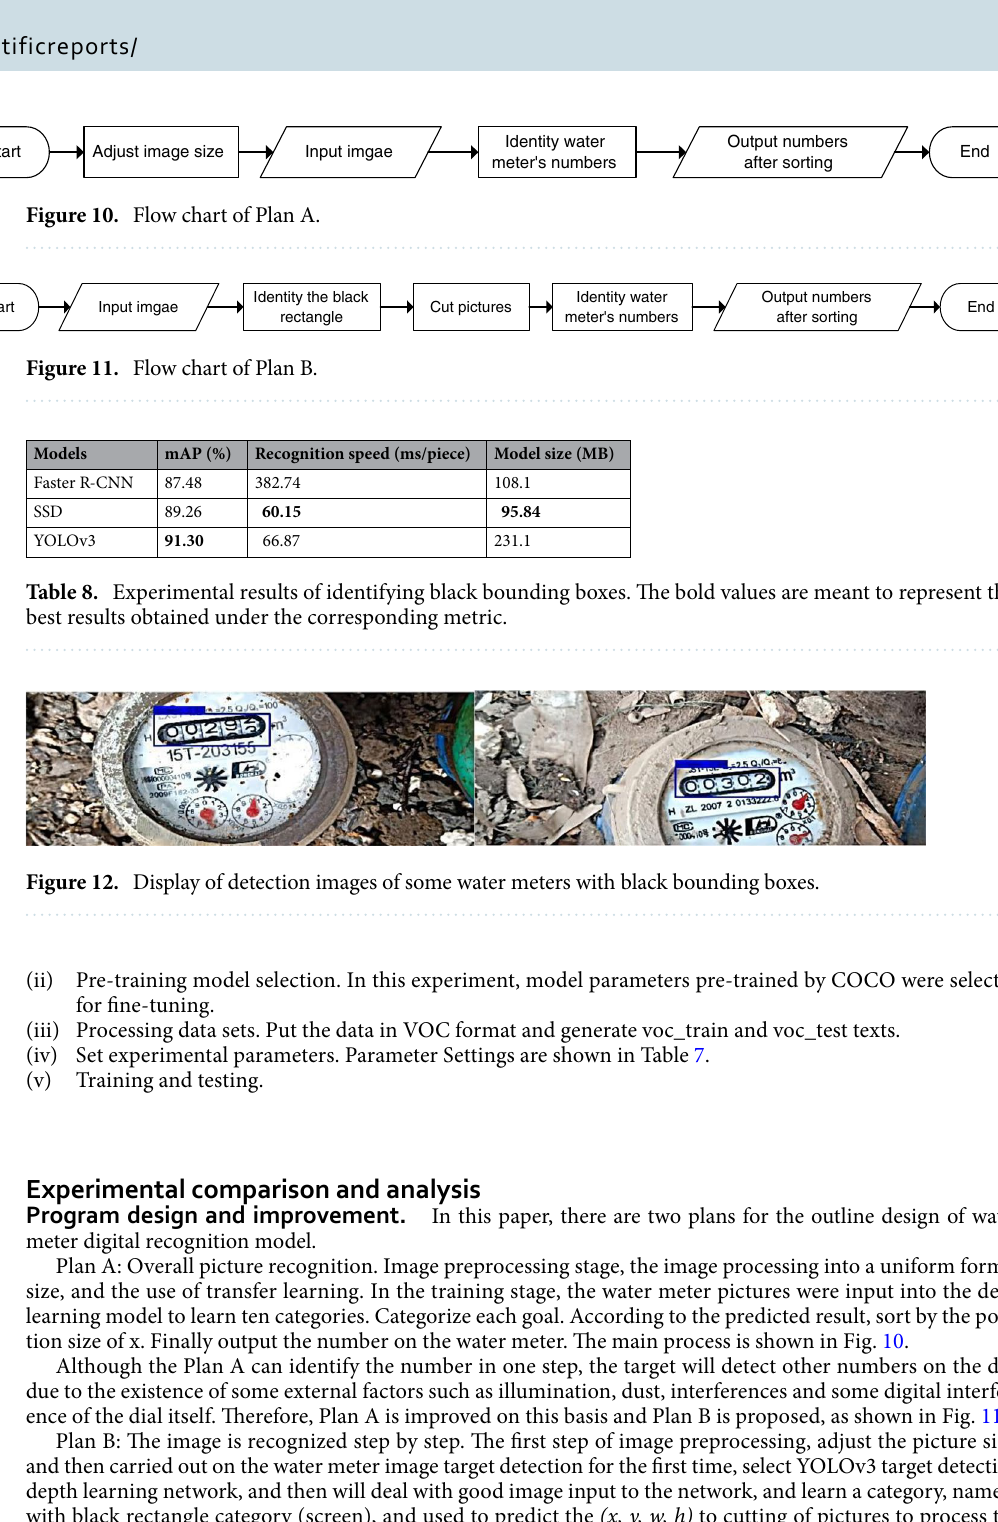
Figure 10. Flow chart of Plan A.